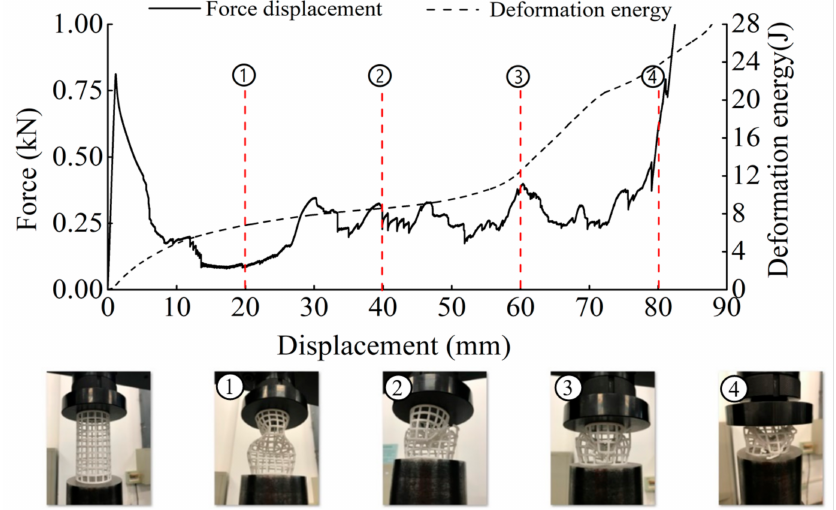
Figure 6. Deformation process of CSHT0 (1–4 stages of deformation during quasi-static compression test).